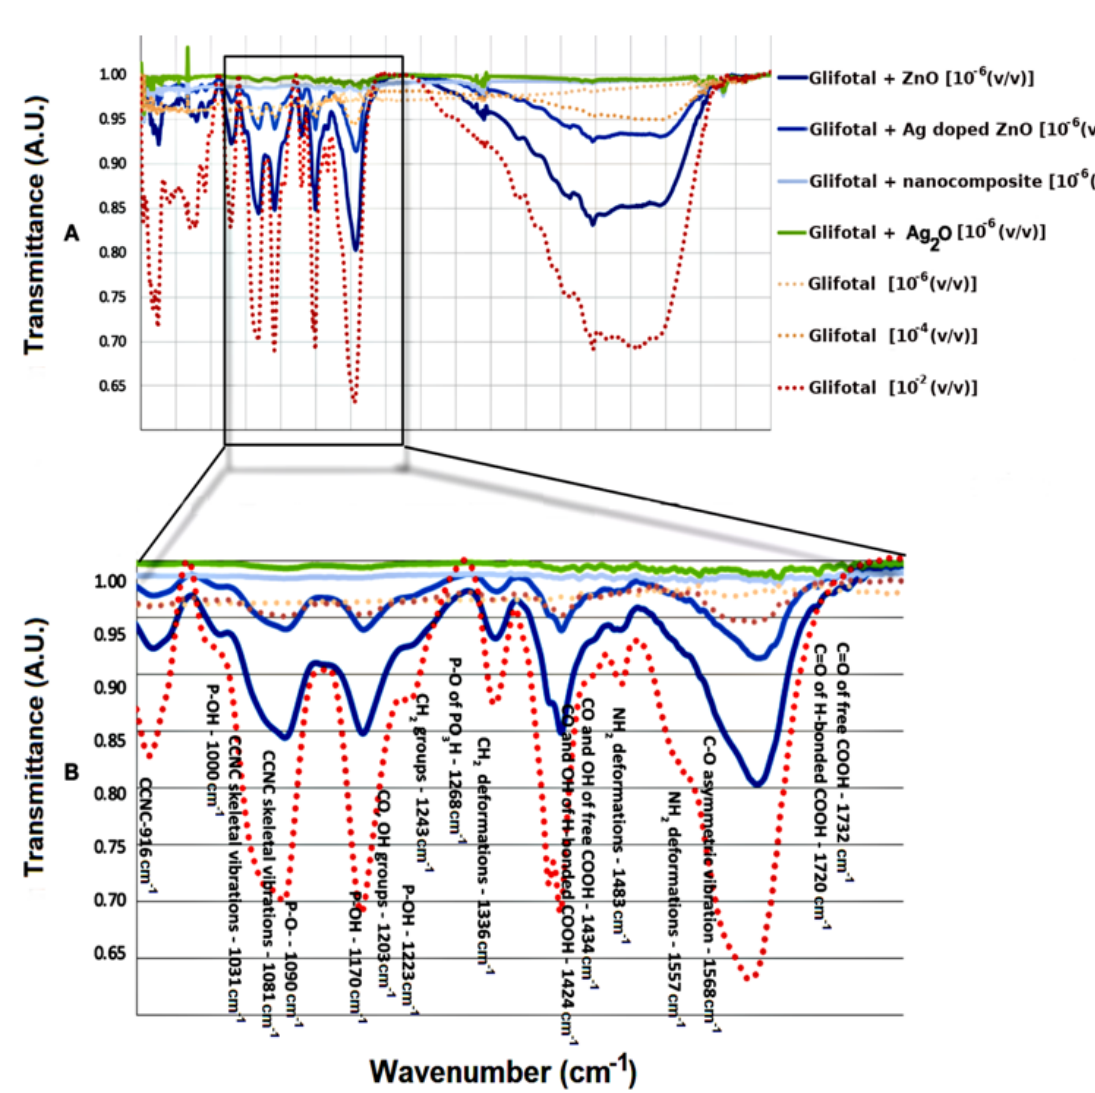
Figure 3. ( A ) FTIR spectra of GLIFOTAL TR at 10 − 2 , 10 − 4 , and 10 − 6 ( v / v ) and GLIFOTAL TR/ NCs at 10 − 6 ( v / v ). ( B ) Spectrum amplification.